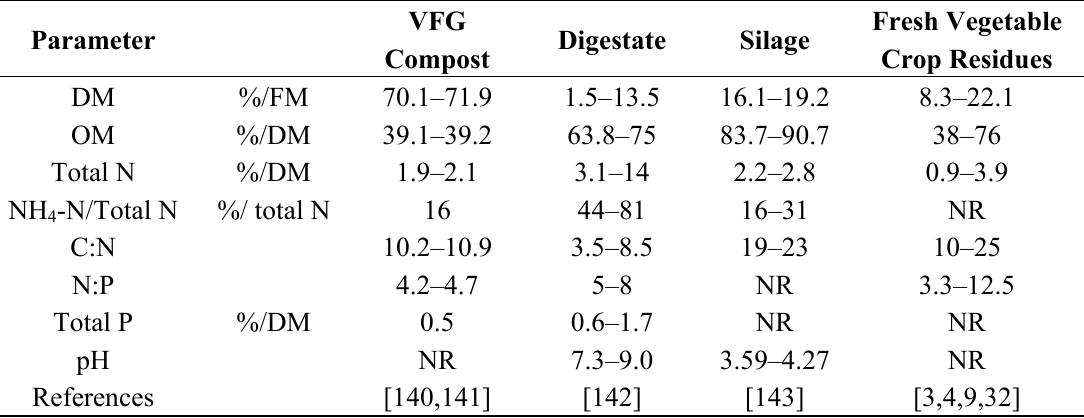
Table 4. Average composition of vegetable, fruit and garden (VFG) compost, digestate without post treatment, ensilaged vegetable crop residues and fresh vegetable crop